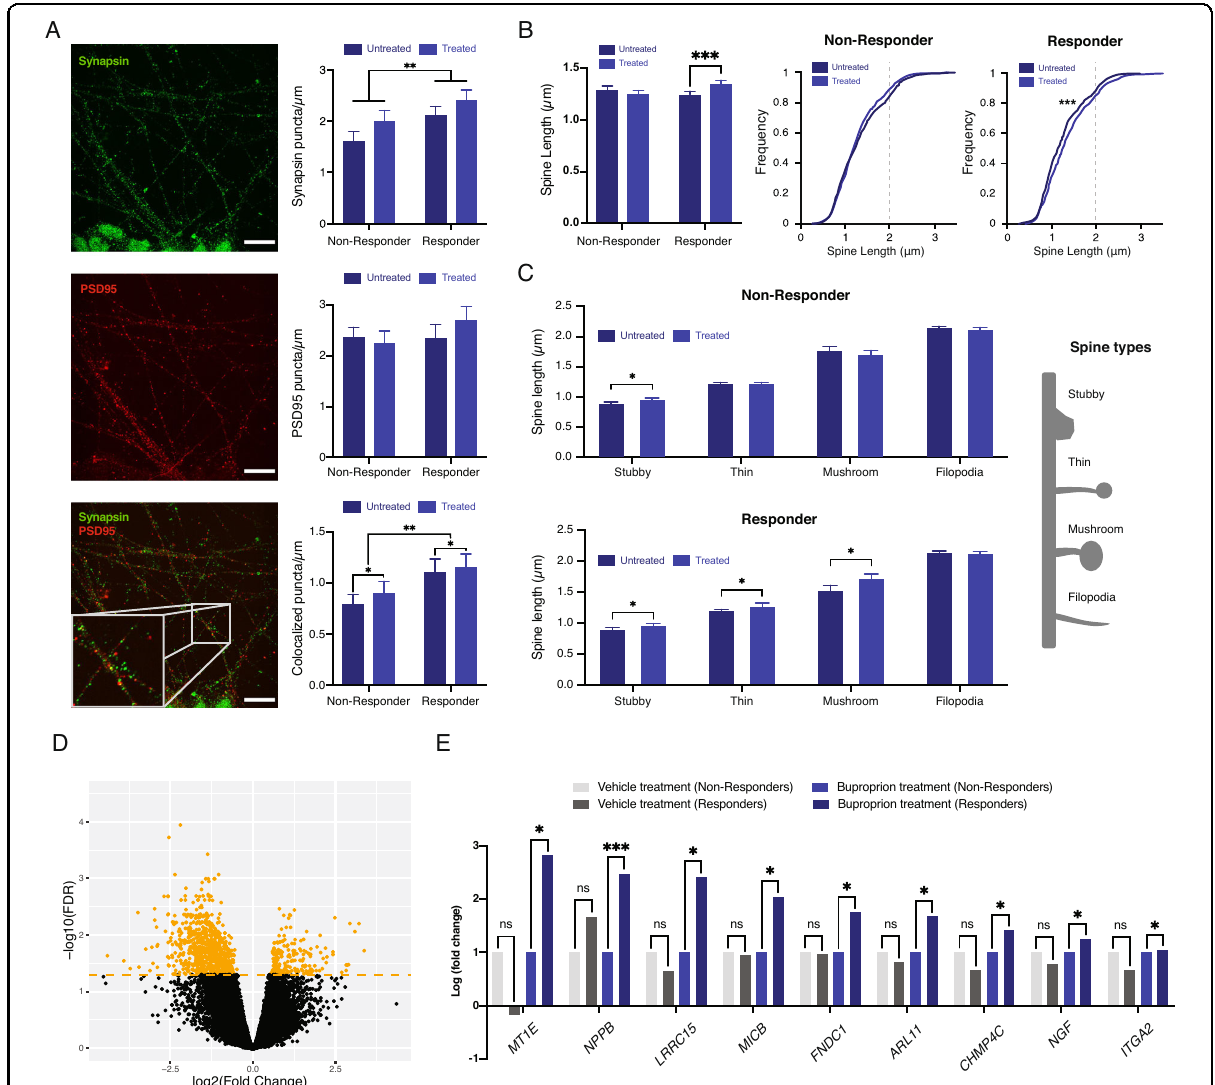
Fig. 2 iPSC-derived cortical neurons mimic patient response to an antidepressant. A Immuno fl uorescence images and quanti fi cations of the presynaptic marker Synapsin (top panel), postsynaptic marker PSD95 (middle panel), and colocalized markers (bottom panel) in nonresponder untreated ( n = 5 patients, n = 52 dendrites), nonresponder bupropion treated ( n = 5 patients, n = 54 dendrites), and responder patient iPSC-derived cortical neurons untreated ( n = 5 patients, n = 39 dendrites) and treated with bupropion ( n = 5 patients, n = 47 dendrites). Scale bars represent 10 µm. B Average dendritic spine length was signi fi cantly altered following bupropion treatment only in patient responder-derived cortical neurons, both in average length and in spine length frequency. C Average dendritic spine length in speci fi c spine types. Spine length was signi fi cantly changed in patient responder-derived neurons in three out of four spine types. Spine types are illustrated (right panel). D Volcano plot of statistically signi fi cant, differentially expressed genes in responder and nonresponder patient-derived cortical neurons following bupropion treatment. Orange line represents FDR < 0.05 (N = 10, n = 5 for each remission group). E Identi fi ed biomarker gene expression signi fi cantly changed in responder patient-derived cortical neurons following bupropion treatment. One-sided Student ’ s t test was used for comparisons. * p < 0.05, ** p < 0.01, *** p < 0.001. Error bars represent standard error of the